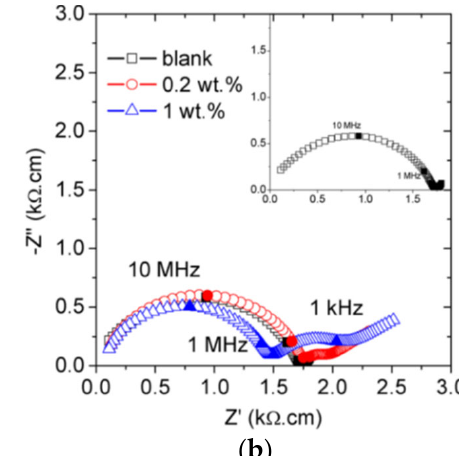
Figure 8. ( a ) Cole–Cole plot showing the dependence of the low-frequency capacitance limit with the water content of a cement paste sample. ( b ) Evolution of the R 2 resistance with the sample’s water content. Figures taken from [29].